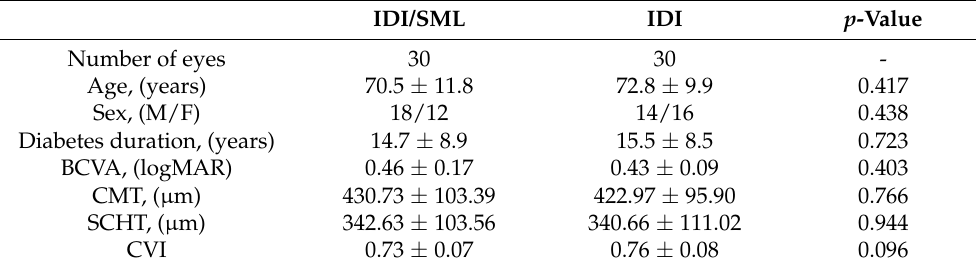
Table 1. Characteristics and anatomical parameters of enrolled patients. All values are ex- pressed as median (1st quartile; 3rd quartile). p -value results from the nonparametric test for independent samples. IDI/SML IDI p -Value Number of eyes